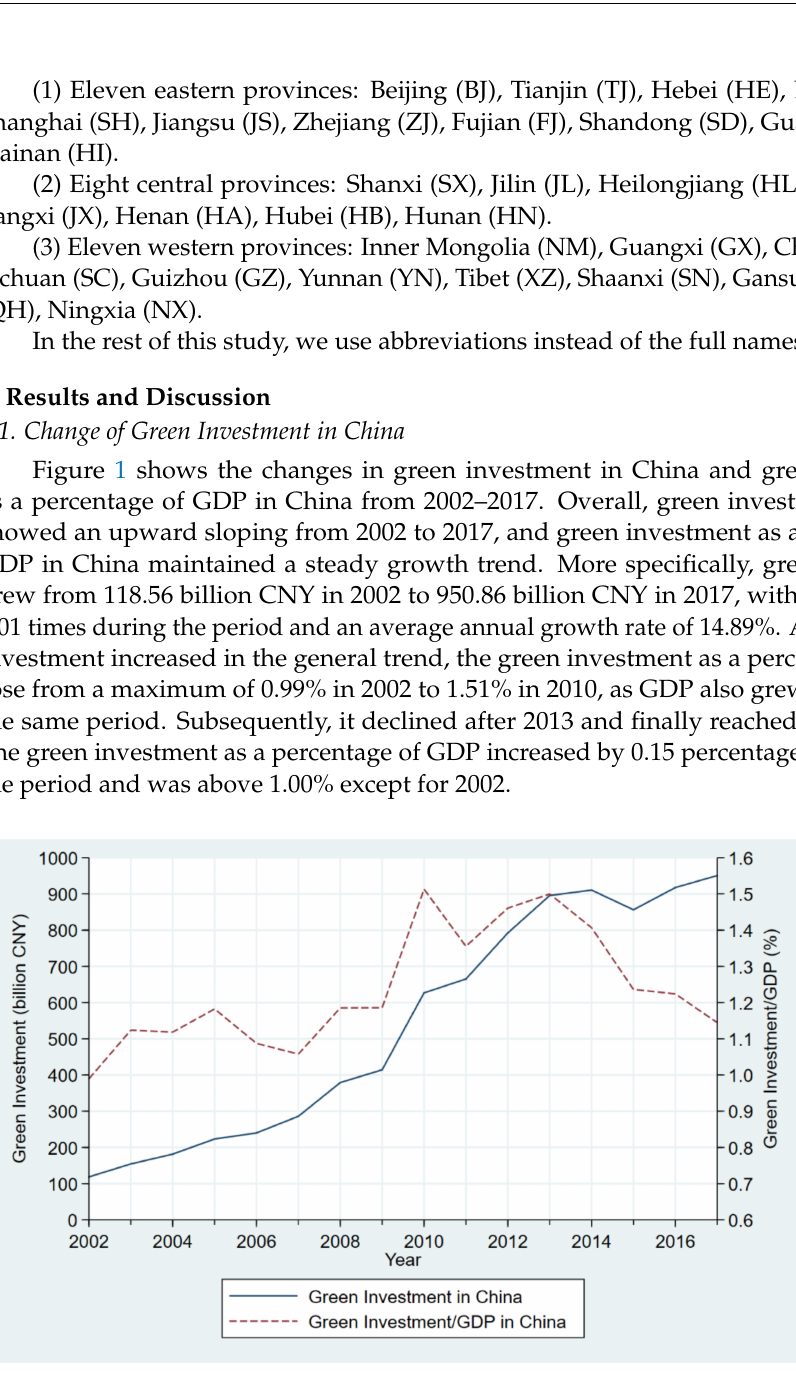
Figure 1. Green investment and green investment/GDP in China during